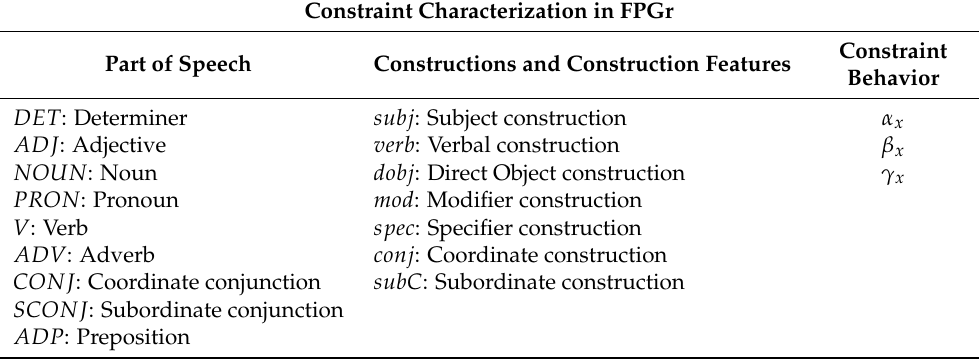
Table 1. Constraint Characterization in FPGr.